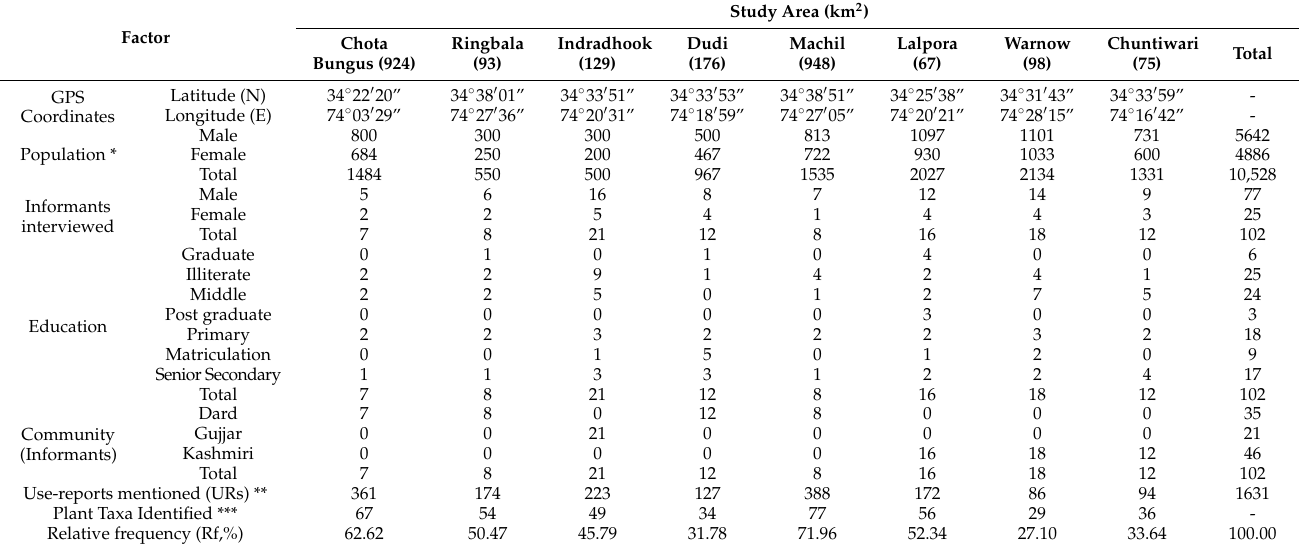
Table 1. Demographic characteristics of the places